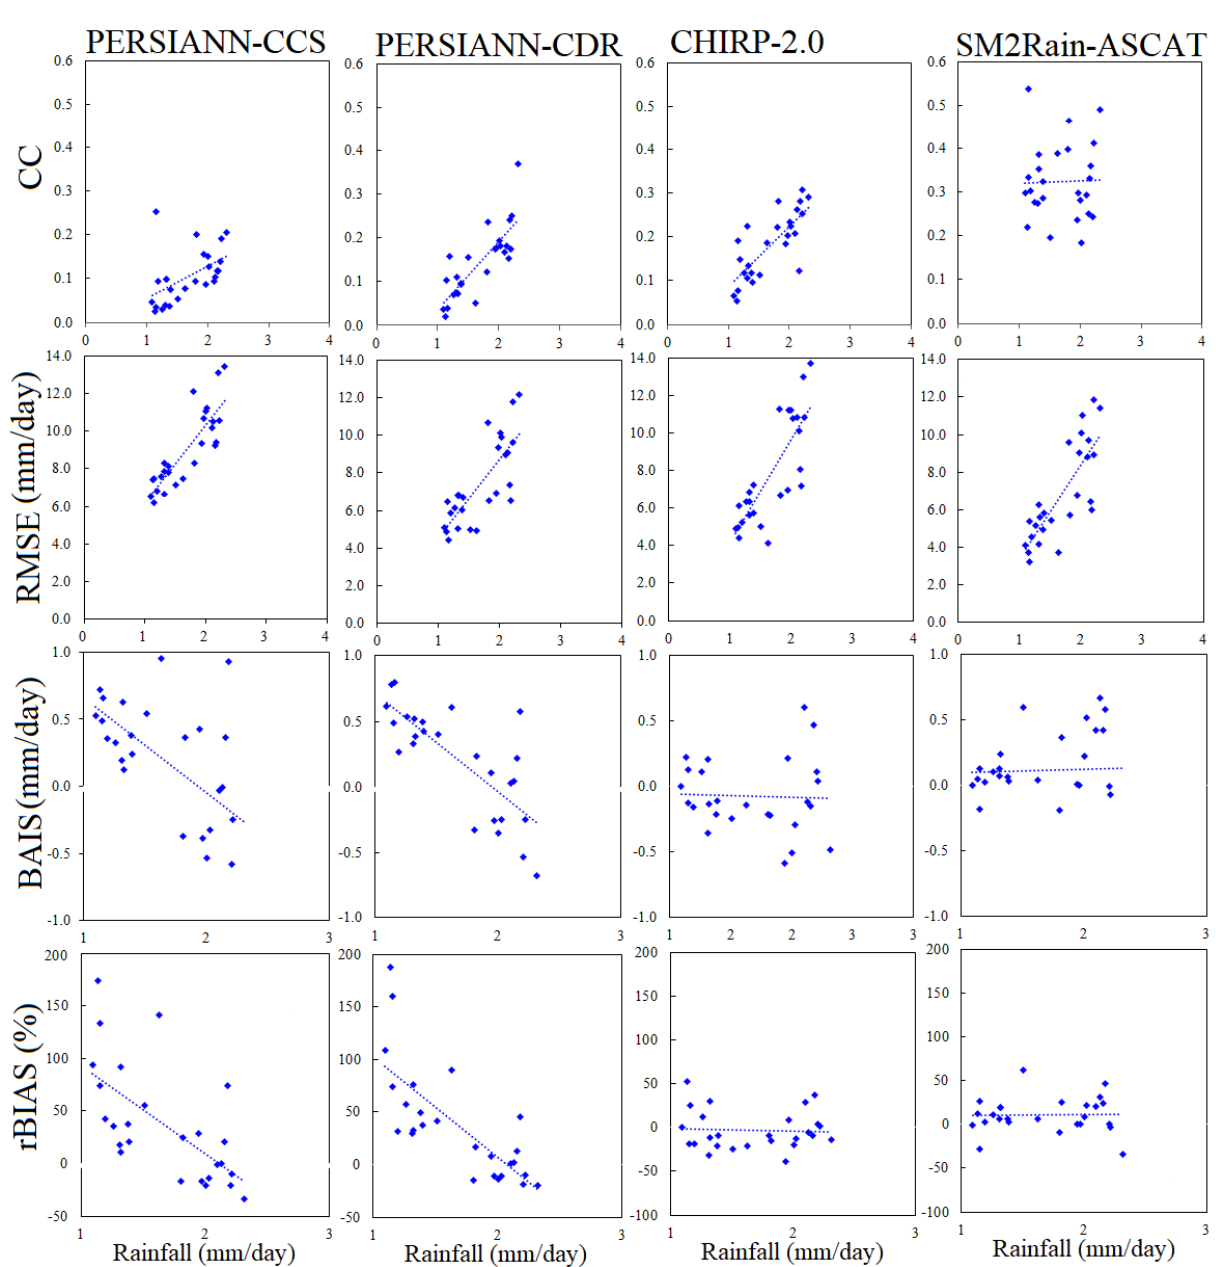
Figure 9. Scatter plots between the assessment indices versus rainfall intensity.